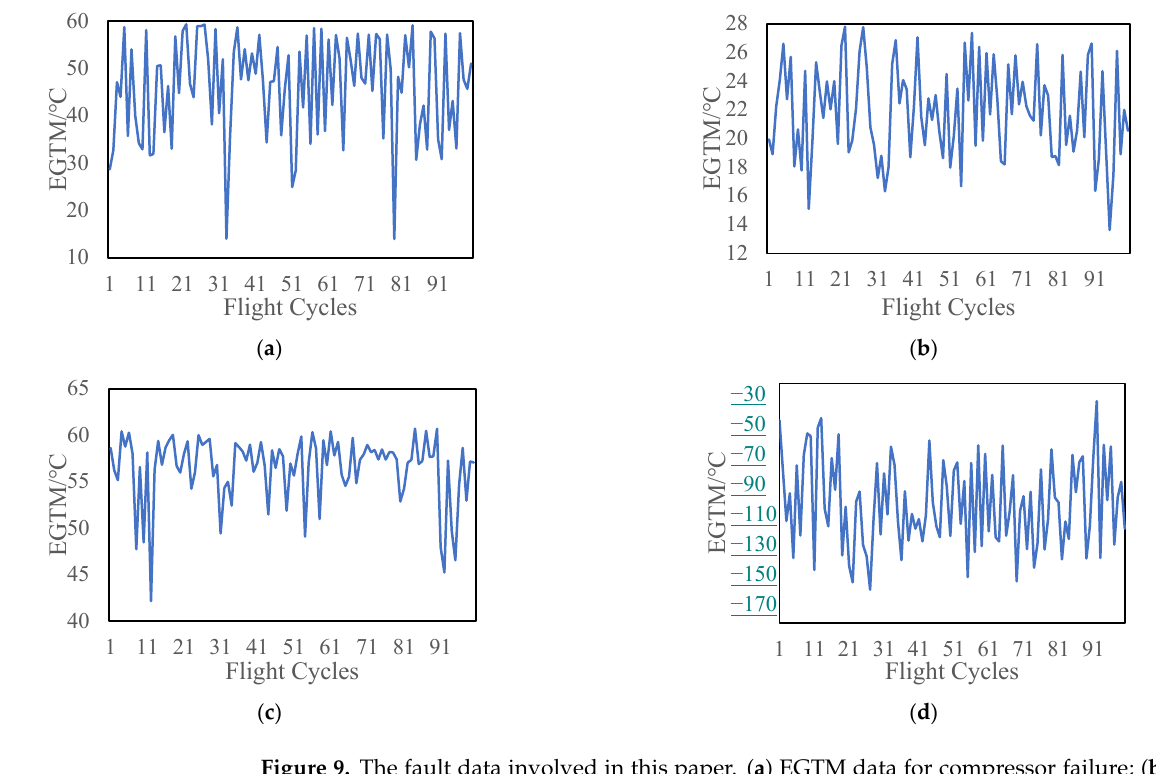
Figure 8. The engine data involved in this paper.